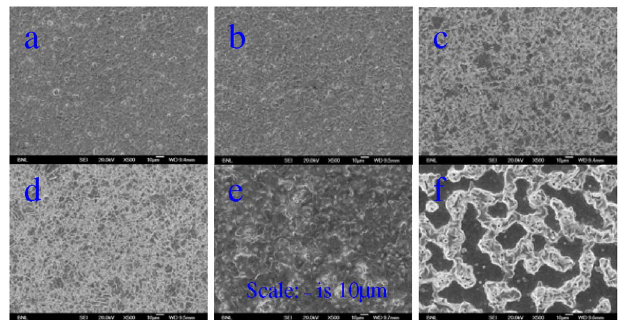
FIG. 5. (Color) Surface structure of a lead coated cathode after 248 nm laser irradiation: (a) no laser (b) 0.11 (c) 0.26 (d) 0.52 (e) 1.1 (f) 1 : 8 mJ = mm 2 .